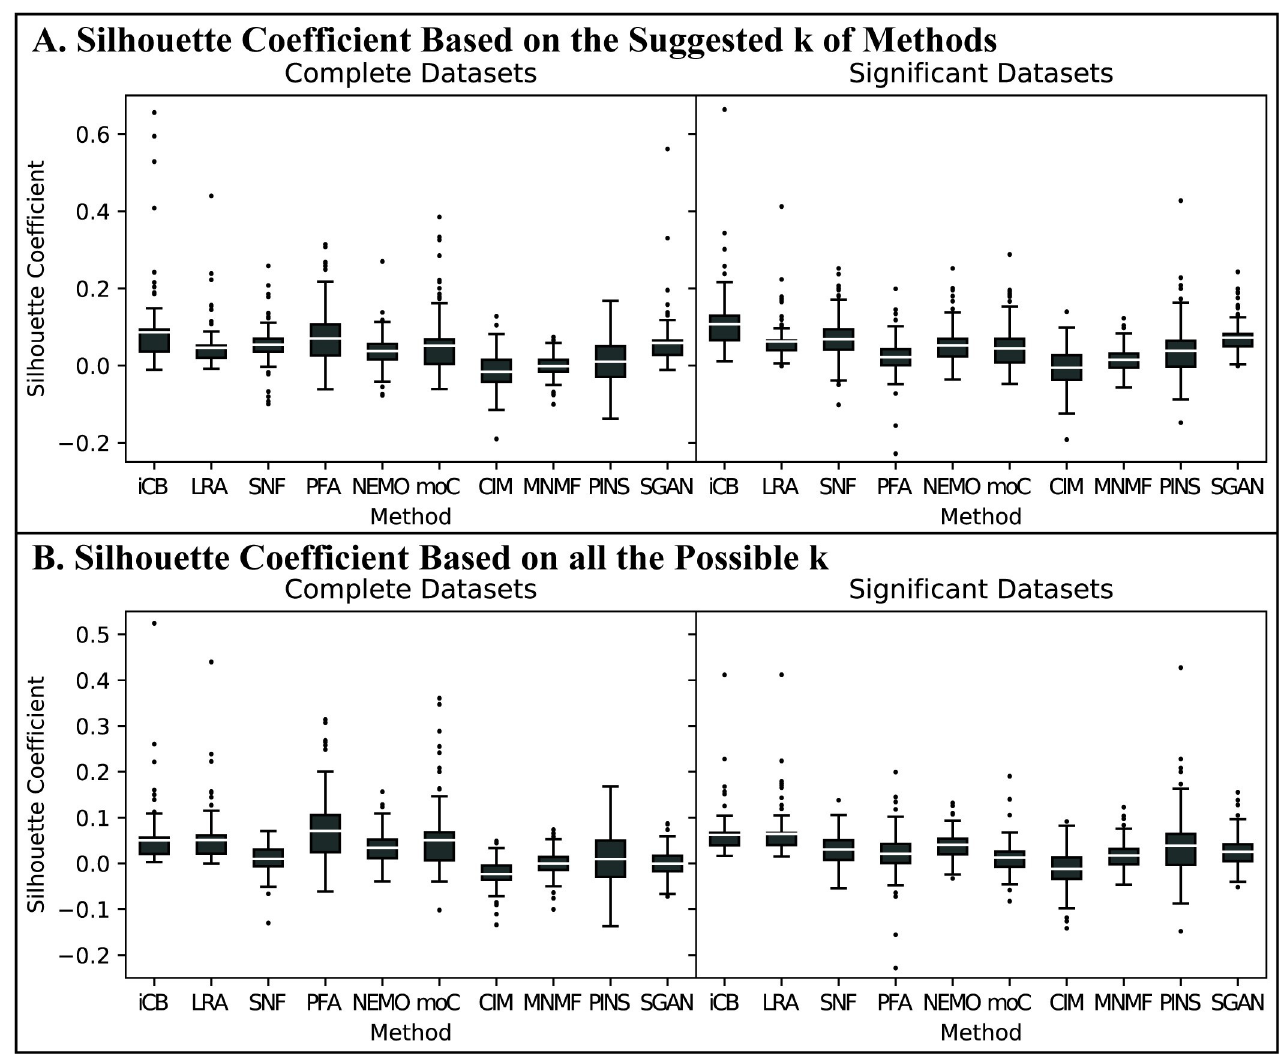
Fig 3. Clustering-based performance of Dataset group #1 Nine-cancer Datasets. We use “iCB”, “LRA”, “moC”, “CIM”, “MNMF”, and “SGAN” to represent iClusterBayes, LRAcluster, moCluster, CIMLR, MultiNMF, and Subtype-GAN respectively. (A) Silhouette coefficient based on the suggested k of methods. We set k -max as 8 and let each method suggest the best k . Each of the 11 data points in a box represents a silhouette coefficient of the subtyping results based on the method suggested k obtained by the corresponding method using one of the 11 possible combinations of data types. (B) Silhouette coefficient based on all the possible k . Each of the 11 data points in a box represents the average silhouette coefficient of the subtyping results from k = 2 to 8 obtained by the corresponding method using one of the 11 possible combinations of data types.